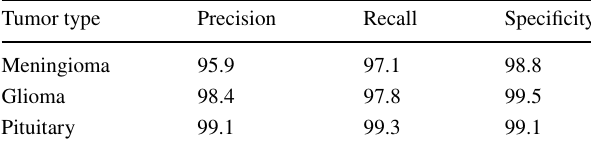
Table 3 Class-specific evaluation of brain tumor classifier Tumor type